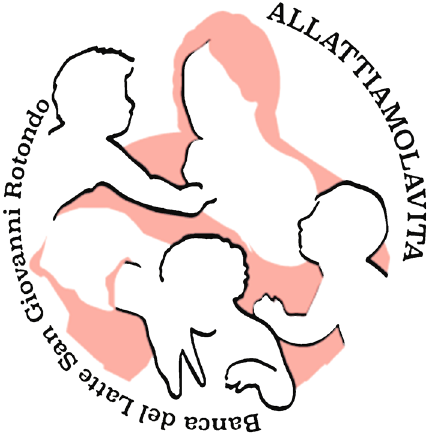
Figure 1: The logo of our HMB (human milk bank).